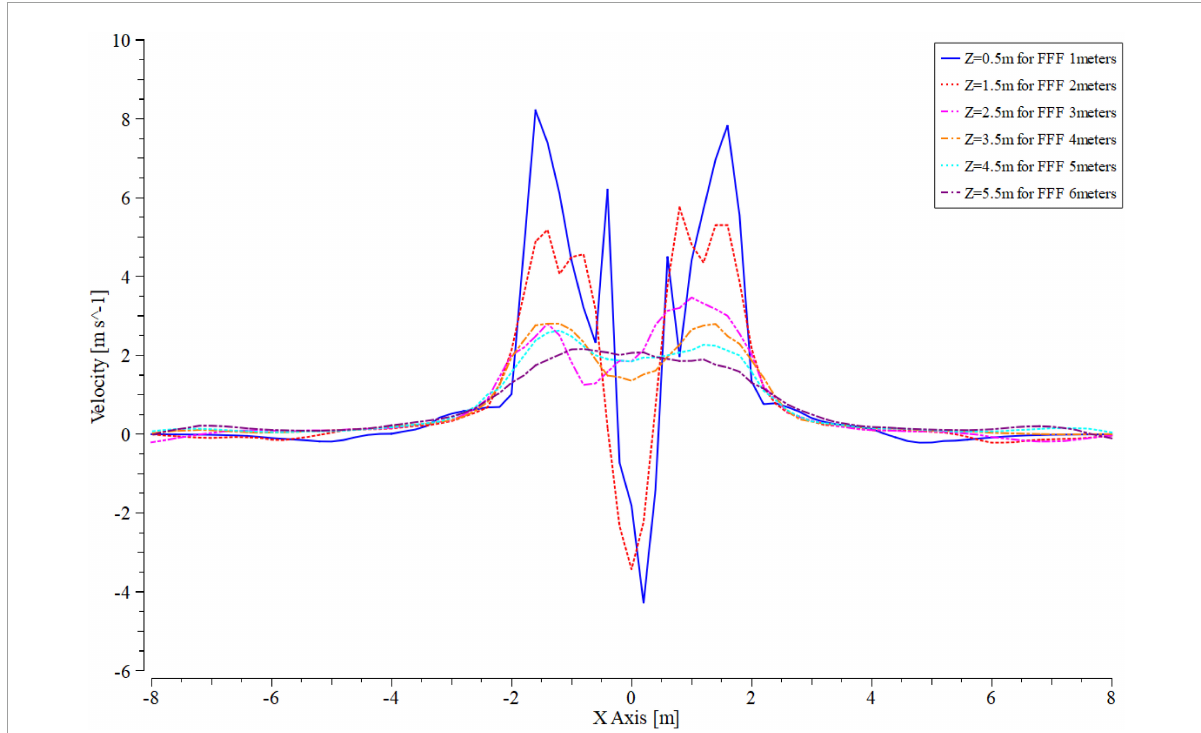
FIGURE12 Velocity variation curve at 0.5 m from the ground at different flight heights. Where “ Z = 0.5 m for 1 m,” “ Z = 1.5 m for 2 m,” “ Z = 2.5 m for 3 m,” “ Z = 3.5 m for 4 m,” “ Z = 4.5 m for 5 m,” “ Z = 5.5 m for 6 m,” the size of the downwash airflow at 0.5 m from the ground when the UAV is flying at 1, 2, 3, 4, 5, and 6 m,